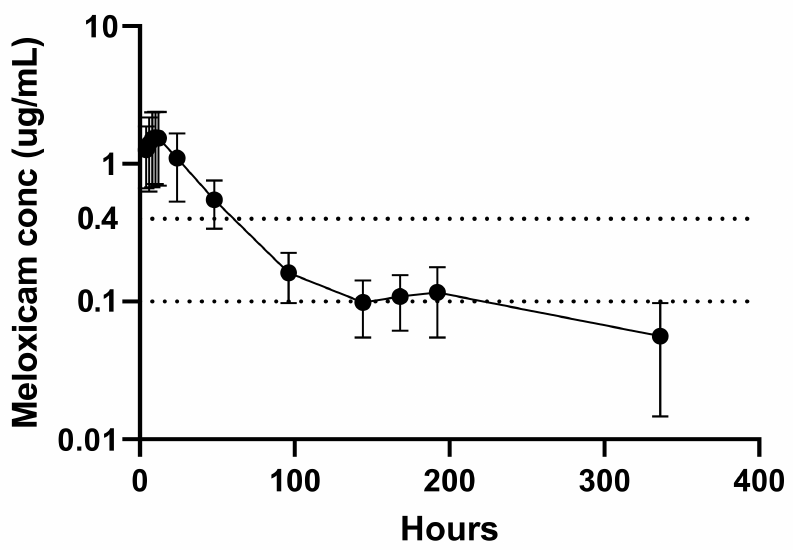
Figure 2. Plasma concentrations (ug/mL) of 2 mg/kg sustained-release meloxicam formulation (SRMF) following subcutaneous administration in sheep ( n = 6) over time. The dotted line at y = 0.1 µ g/mL is the lower limit of quantification of the assay [12]. The dotted line at y = 0.4 µ g/mL is a theoretical plasma analgesic